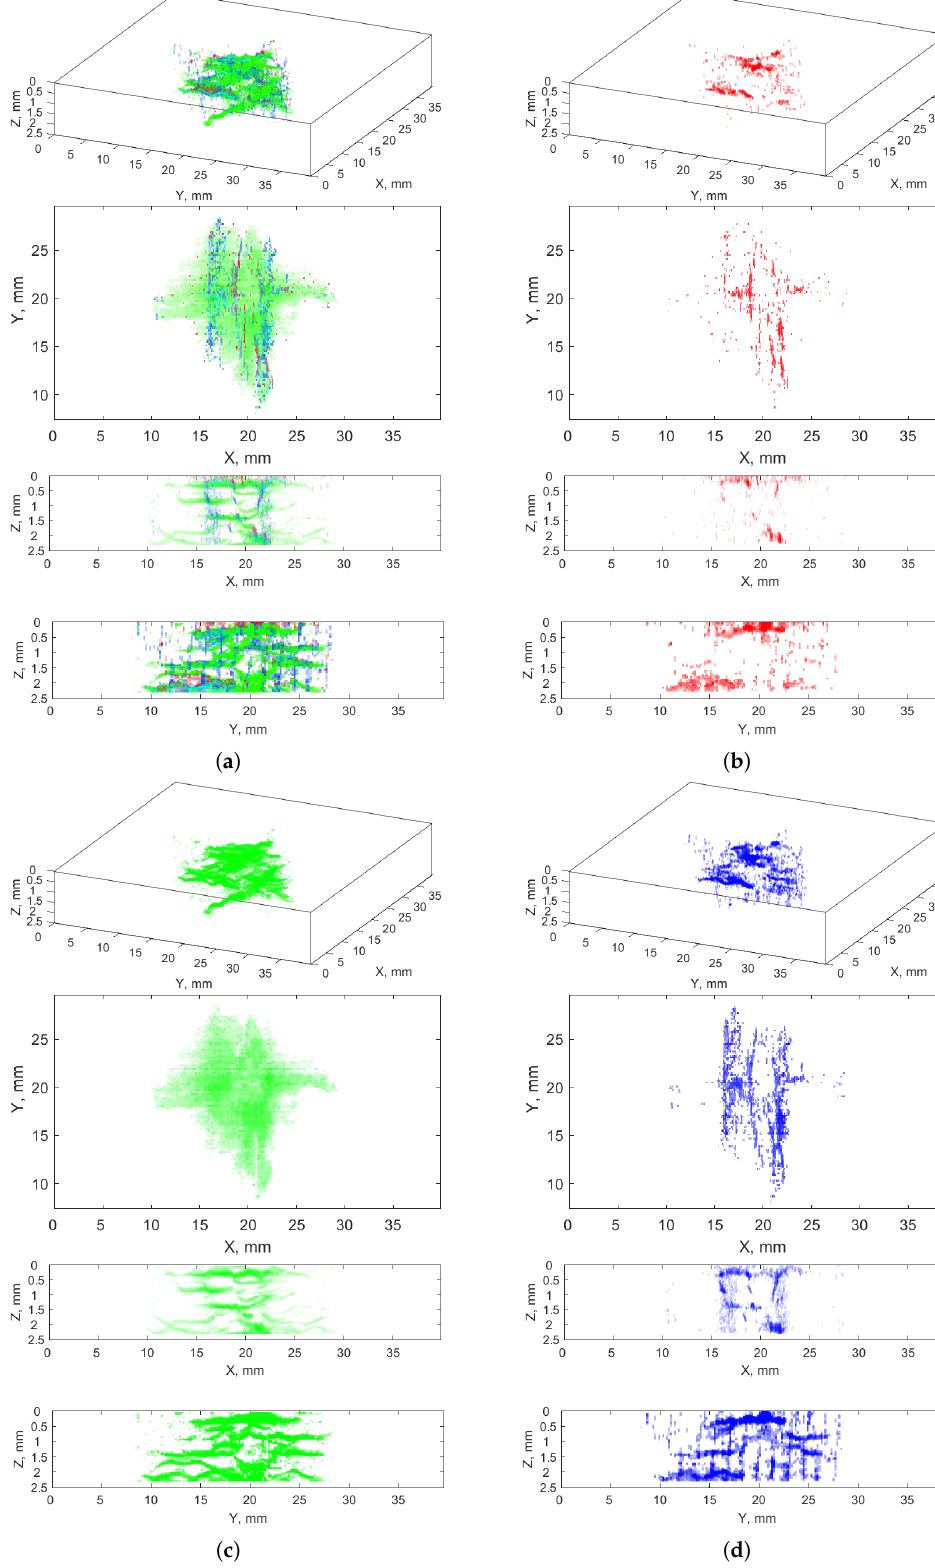
Figure 10. Wavelet-based masks obtained from the implementation of the proposed algorithm for V—vertical, H—horizontal, D—diagonal components: ( a ) V, H, and D; ( b ) V; ( c ) H; ( d )